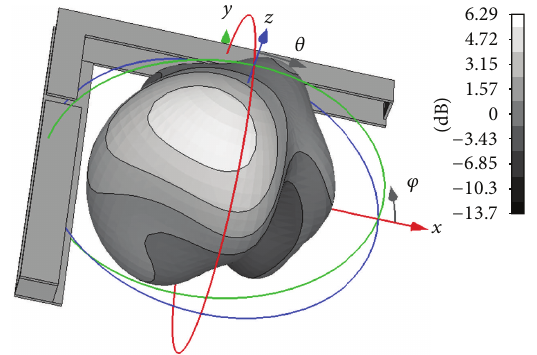
Figure 16: Simulated 3D antenna gain (dBi) for the dual-band L- shape PIFA at 2440MHz.